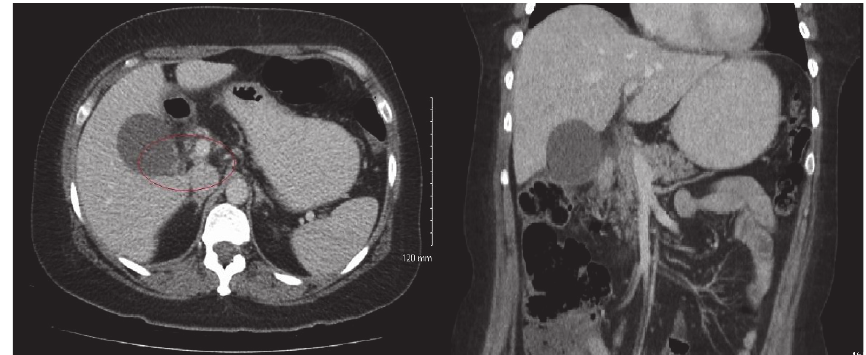
Figure 1: CT abdomen pelvis day 2: periportal and pericholecystic fat stranding with hyperaemia of the extrahepatic bile duct and adjacent stranding. Findings are suspicious for an ascending cholangitis and